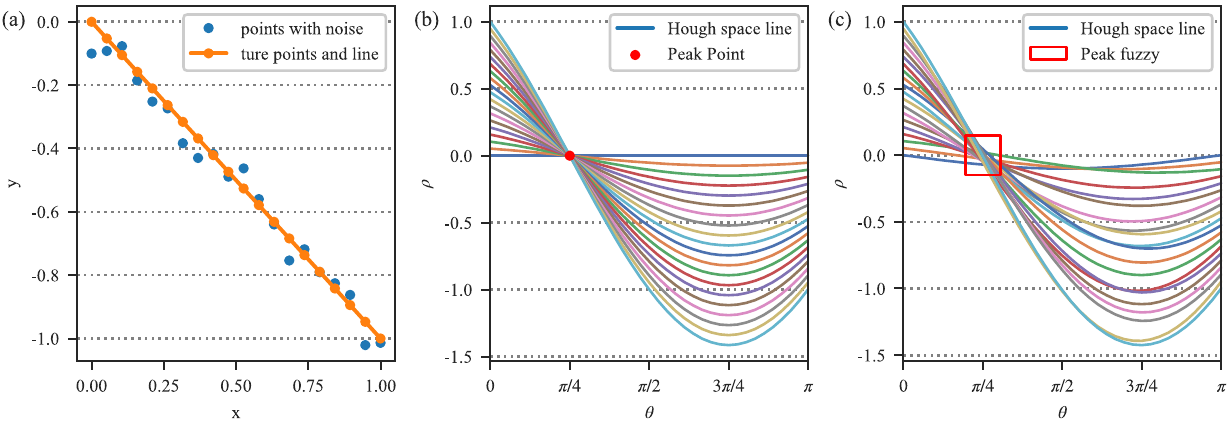
Figure 3. Schematic of peak fuzziness: ( a ) Cartesian coordinate system points; 2D points with noise (blue) bounce around true points (orange), and the orange line indicates the true line ( y = − x − 1); ( b ) transforming the true points to the Hough parameter space, one line indicates one point in the Cartesian coordinate system, and the red dot indicates the intersection of all lines; ( c ) Hough param- eter space with noise; transforming the points with noise to the Hough parameter space, one line indicates one point in the Cartesian coordinate system, and the red box shows the peak